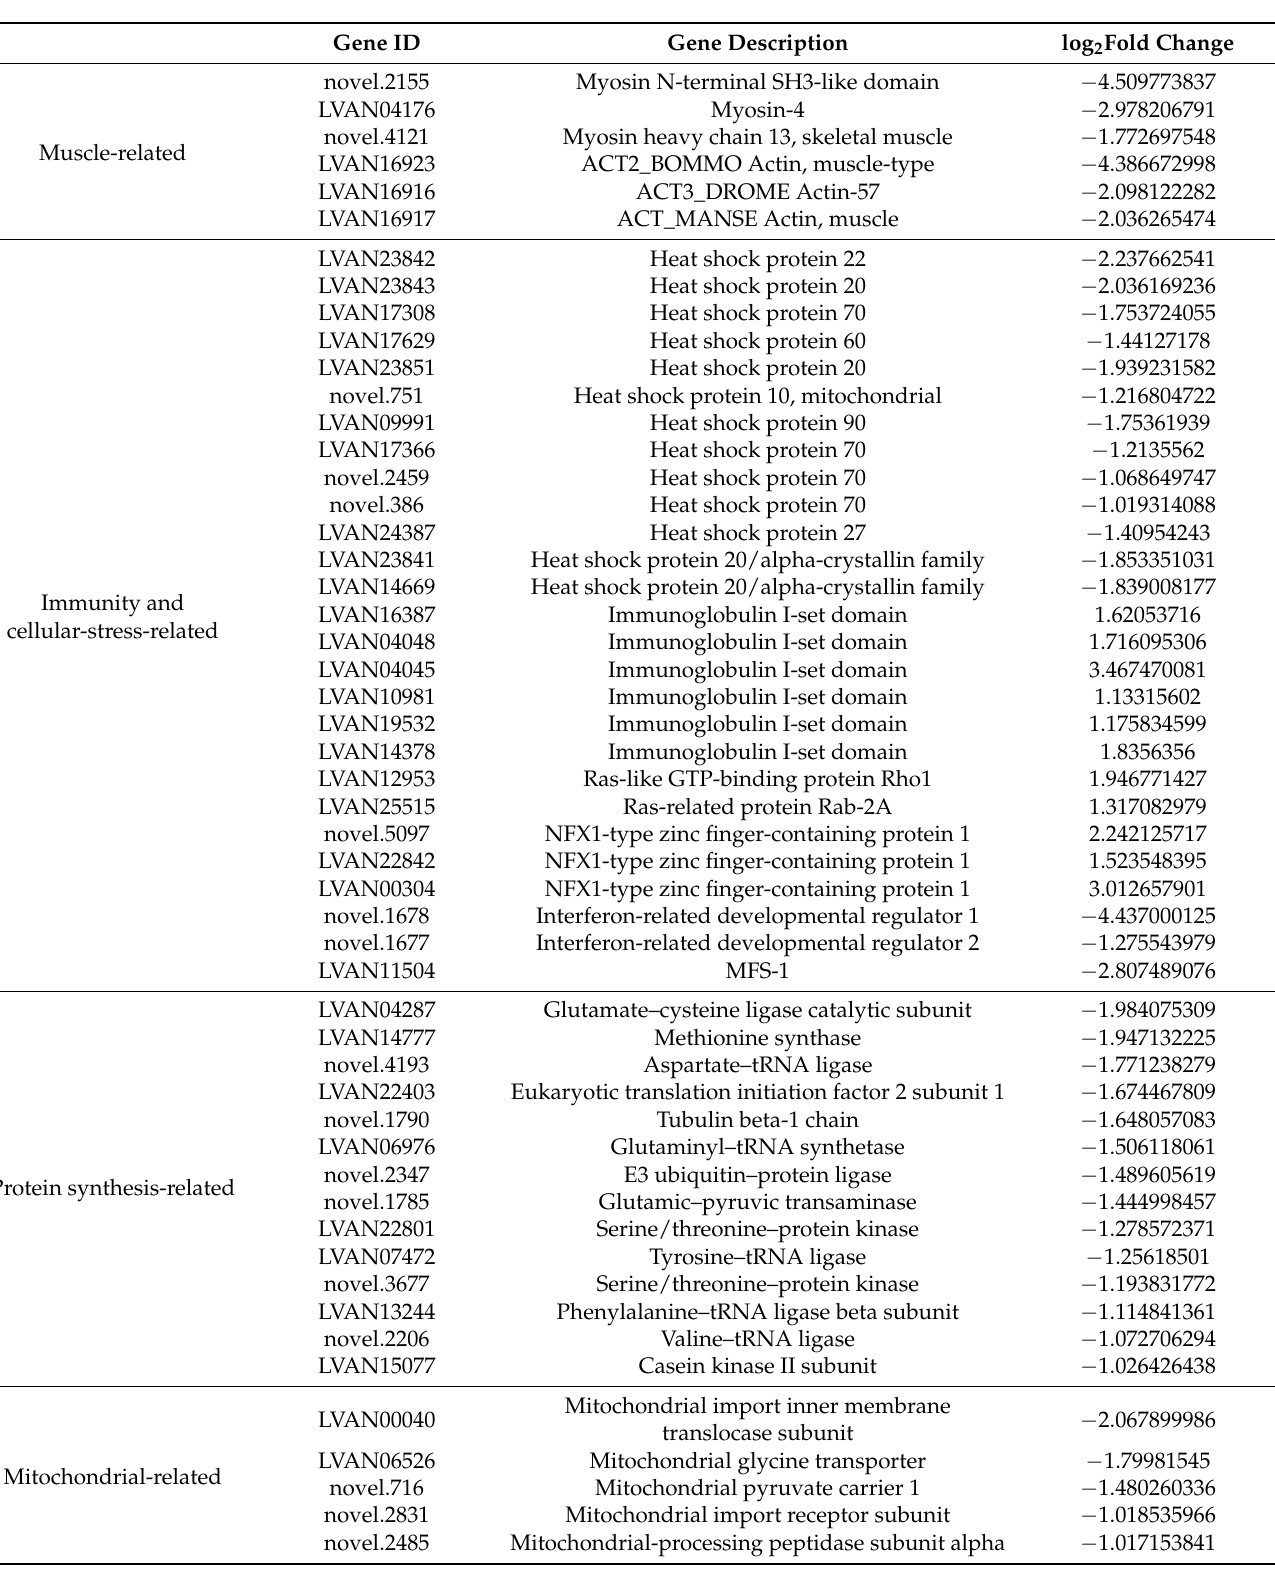
Table 2. Differentially expressed genes enriched in muscle after LvMEF2